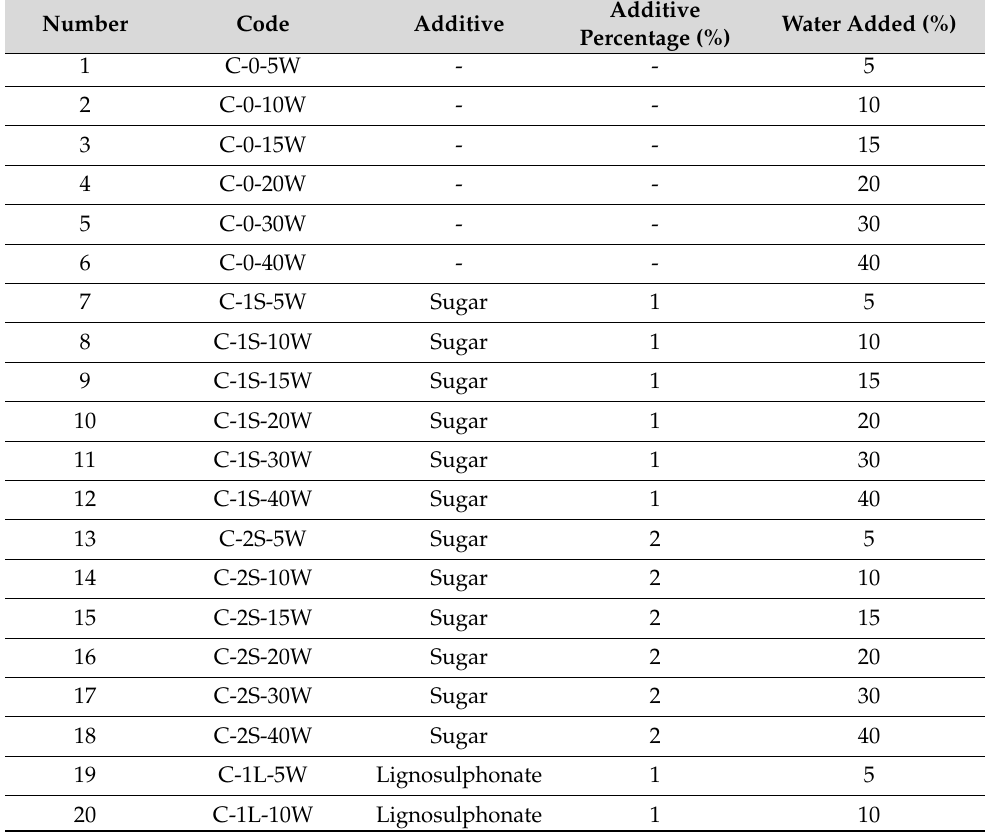
Table 2. Laboratory investigation